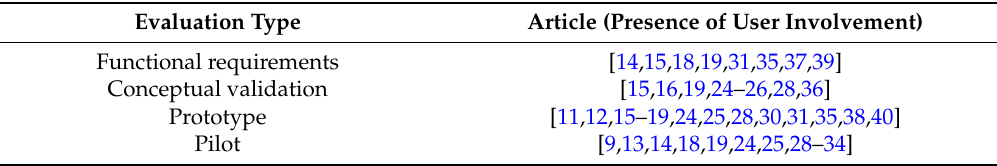
Table 3. Articles that refer to user involvement.